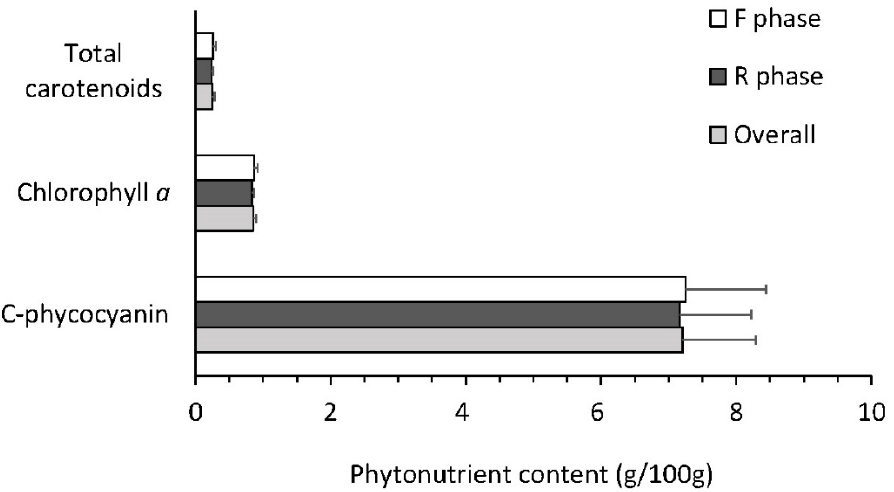
Figure 3. Average phytonutrient content (as % of C-phycocyanin, chlorophyll a , and total carotenoids) for samples of A. platensis BEA 1257B biomass collected at the first phase (F phase, 12 Sep. to 11 Oct., samples F1, F2 and F3) and at the second phase of the experiment (R phase, 11 Oct. to 11 Nov., samples R1, R2 and R3) from the 8000 L raceway pond inside greenhouse during the long-term semi-continuous cultivation. Overall phytonutrient content in the biomass is also reported. Data are presented as the mean of three samples for F and R phase, and as the mean of six samples for Overall, with error bars representing the corresponding standard deviation (±SD). Legend: White graph bars—F phase; Black graph bars—R phase; Gray graph bars—Overall experiment. Table 3. Mineral composition (in mg/100 g), trace metals (in mg/100 g) and heavy metal content (in mg/kg) in A. platensis BEA 1257B biomass samples collected during the first phase (F phase, 12 Sep. to 11 Oct., samples F1, F2 and F3) and during the second phase of the experiment (R phase, 11 Oct. to 11 Nov., samples R1, R2 and R3) from the 8000 L raceway pond inside greenhouse. Overall con- tent in the biomass is also reported. Data are presented as the mean ± SD of three samples for F and R phase, and as the mean ± SD of six samples overall.